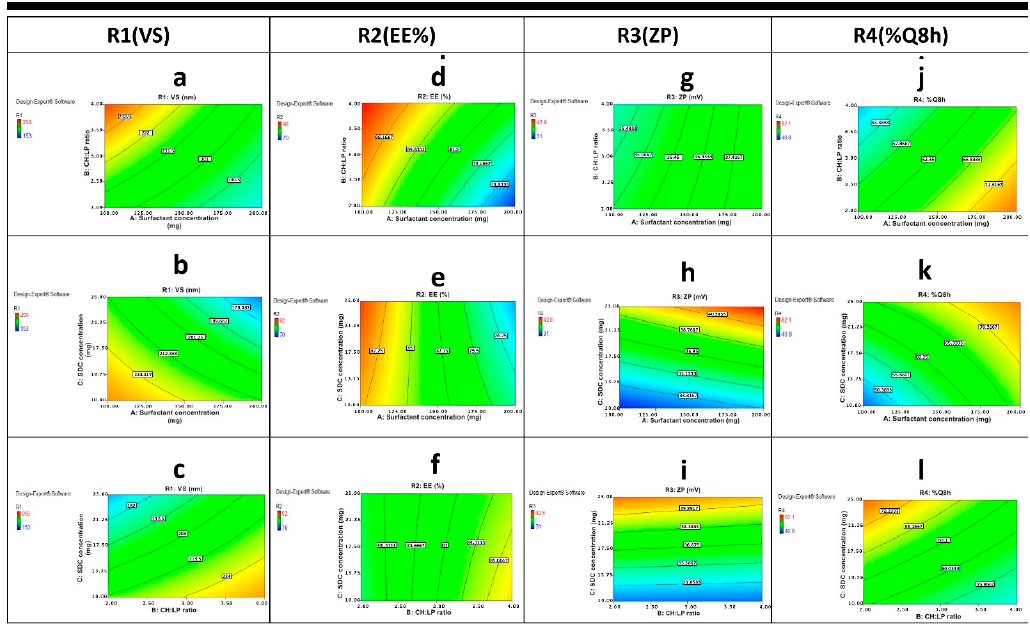
Figure 3. Contour plots of the effect of variables; (A) surfactant concentration, (B) CH:LP molar ratio, and (C) SDC concentration on different of responses R1 (VS), R2 (EE%), R3 (ZP) and R4 (%Q8